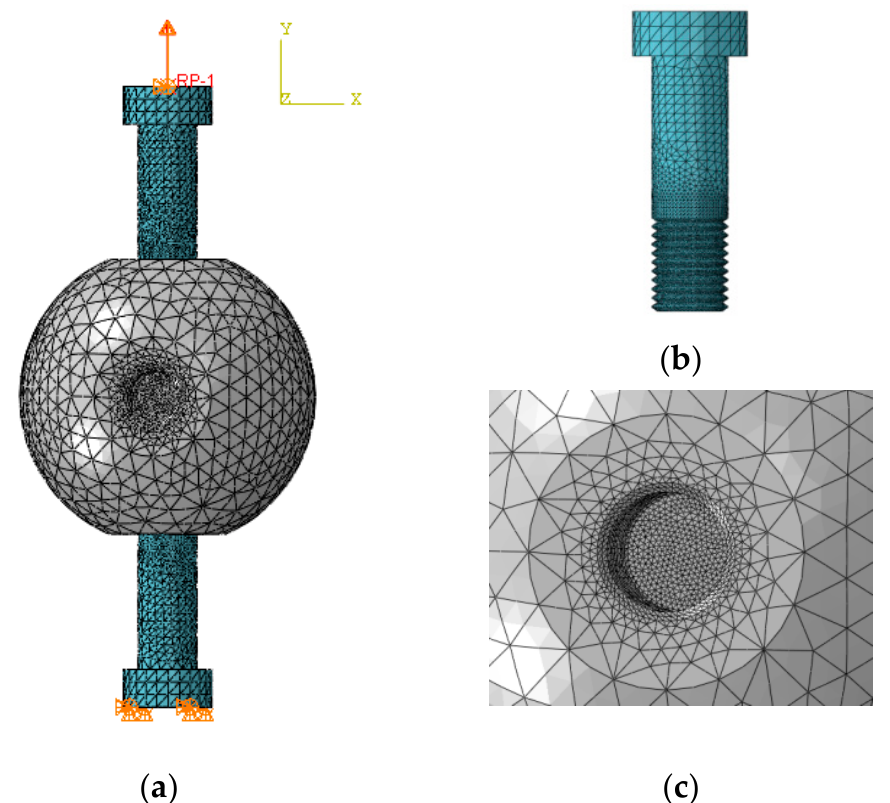
Figure 13. FE model of a typical bolt-sphere connection: ( a ) the whole model; ( b ) the bolt; ( c ) bolt hole.